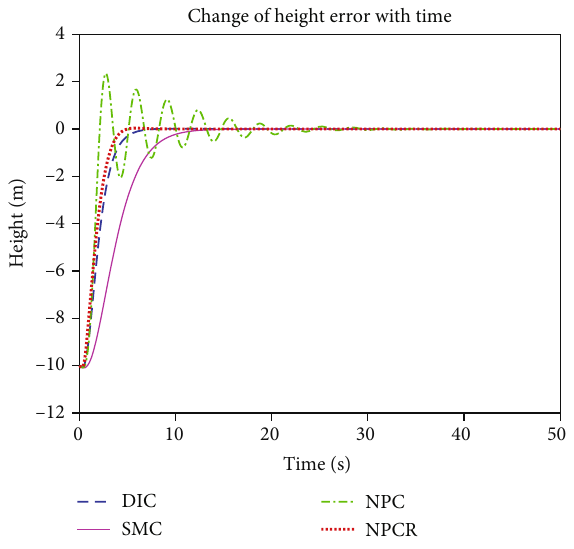
Figure 7: Velocity changes with time under di ff erent prediction steps.